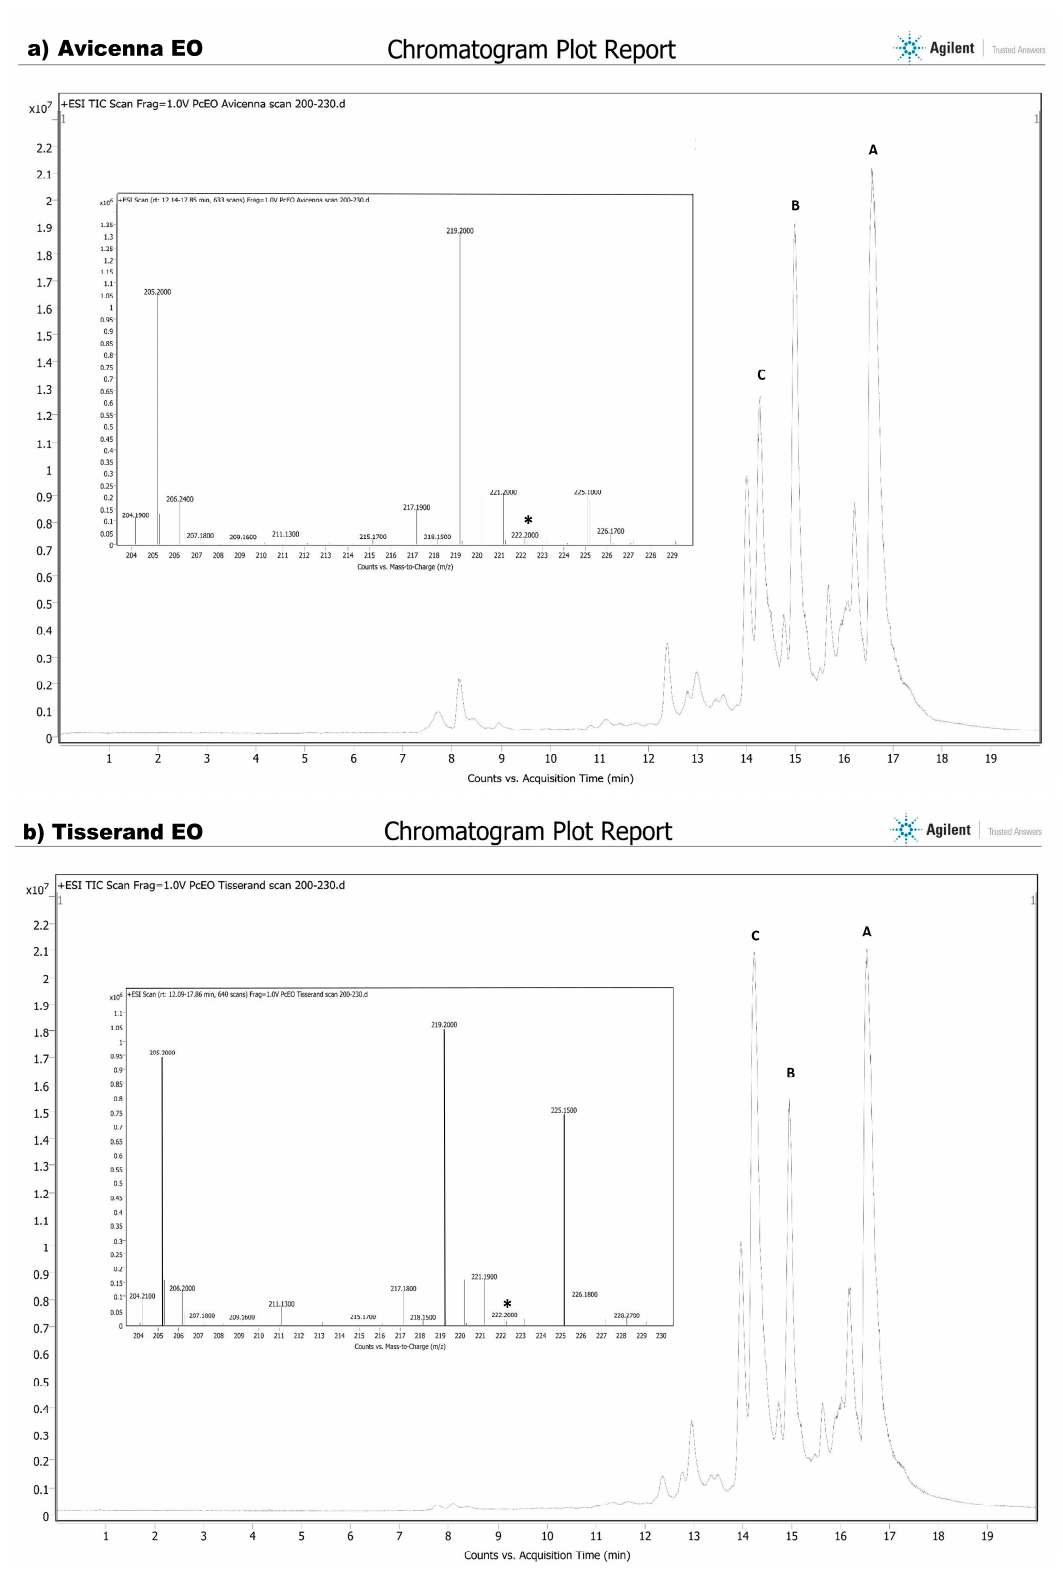
Figure 1. Chromatograms and mass spectra for the patchouli oils under study: Avicenna EO ( a ) and Tisserand EO ( b ). A—major peak for mass 205.2 m / z , B—major peak for mass 219.2 m / z , C—major peak for mass 225.2 m / z . *—potential position of nonmodified patchouli alcohol—patchoulol (222.4 m / z ).